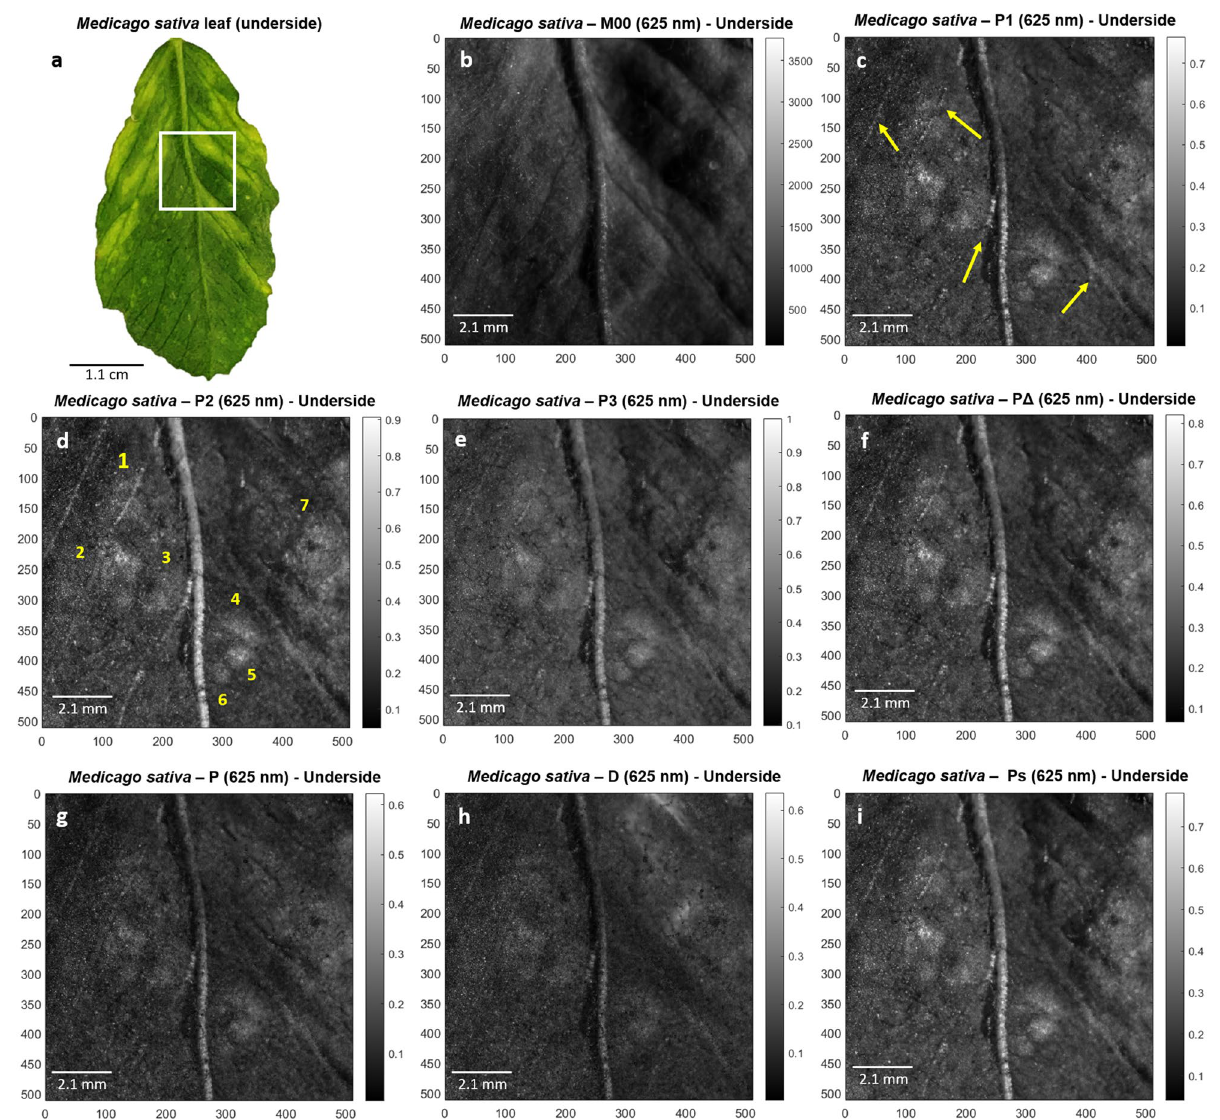
Figure 1. Polarimetric images of Medicago sativa leaf used in this study. ( a ) Picture of the underside part of the Medicago sativa leaf. White square denotes for selected region of interest (ROI) analyzed in remaining images, ( b ) regular intensity image (M 00 ) of the M. sativa underside ROI and its corresponding polarimetric observables ( c ) P correspond to the enhanced vascular structures within the sample, whereas numeric labels (from 1 to 7) indicate the number of chlorotic spots unraveled by means of polarimetric leaves measured in scattering and transmission configuration, respectively, at a wavelength of 625 nm because they represent the most relevant and interesting findings in terms of image enhancement using the polarimetric approach. With regards to the illumination channel selection, 625 nm wavelength light penetrates more deeply into the sample than shorter wavelengths (530 nm or 470 nm in our case). In this way, in the case of O. europaea leaf, light is capable to reach the opposite surface of the leaf, providing information about the diseased tissues at all depth levels. Similar behavior occurs for M. sativa leaf, where 625 nm illumination wavelength measure- ments provide a more accurate description of the lesions. Complementary measurement configurations and their respective obtained polarimetric images are presented in Supplementary Figs. S1 and S2. For the optimal presentation and interpretation of results, we perform a qualitative analysis by comparing the acquired standard intensity images with the polarimetric observables described in “Methods” section. For consistency, the analysis is complemented with quantitative study regarding the polarimetric behavior on dif- ferent structures of healthy and diseased tissues of samples. We also present a pseudo-colored approach image technique that allows a better visualization of certain healthy and diseased plant structures.